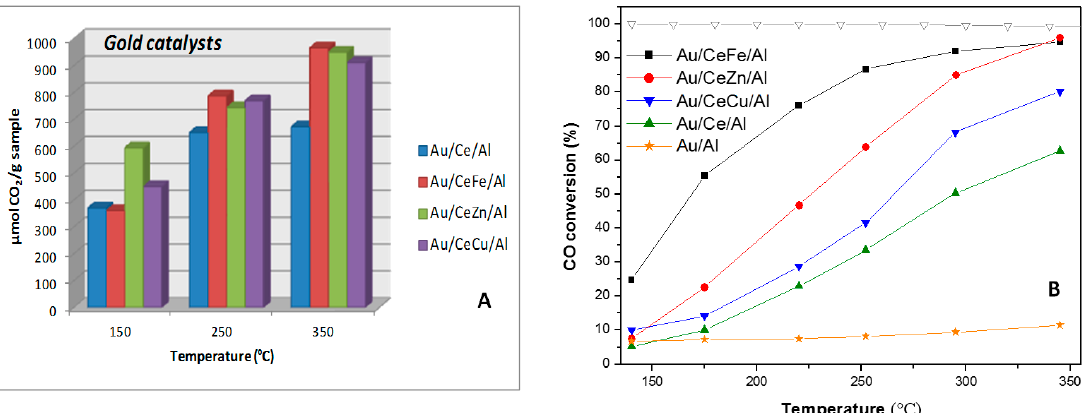
Figure 10. Oxygen storage capacity (OSC) ( A ) and catalytic activity ( B ) of several Au/CeO 2 /Al 2 O 3 -doped systems. Reproduced with permission from [142]. Copyright Elsevier, 2015.